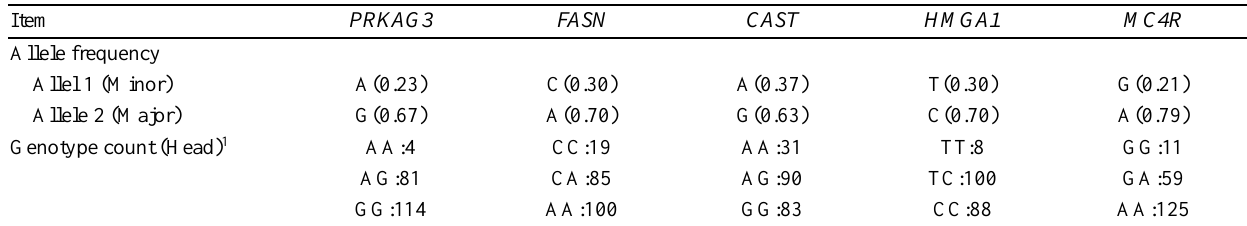
Table 2. Allele and genotype freuquencies of studied polymorphism of the candidate genes in Duroc breeding